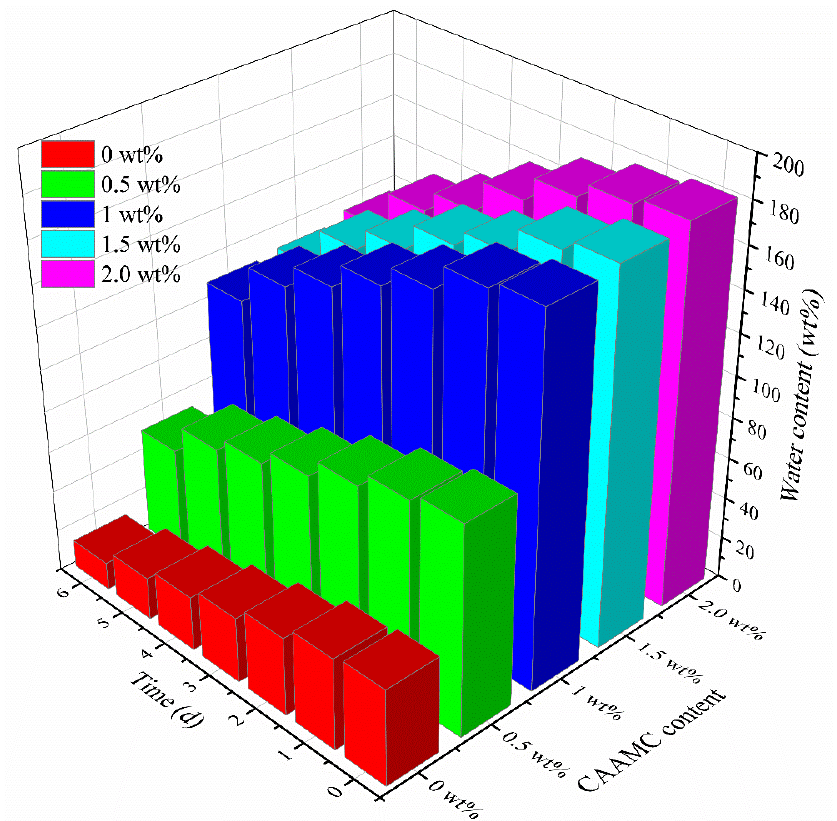
Figure 12. Water retention effect of soils with different CAAMC contents.